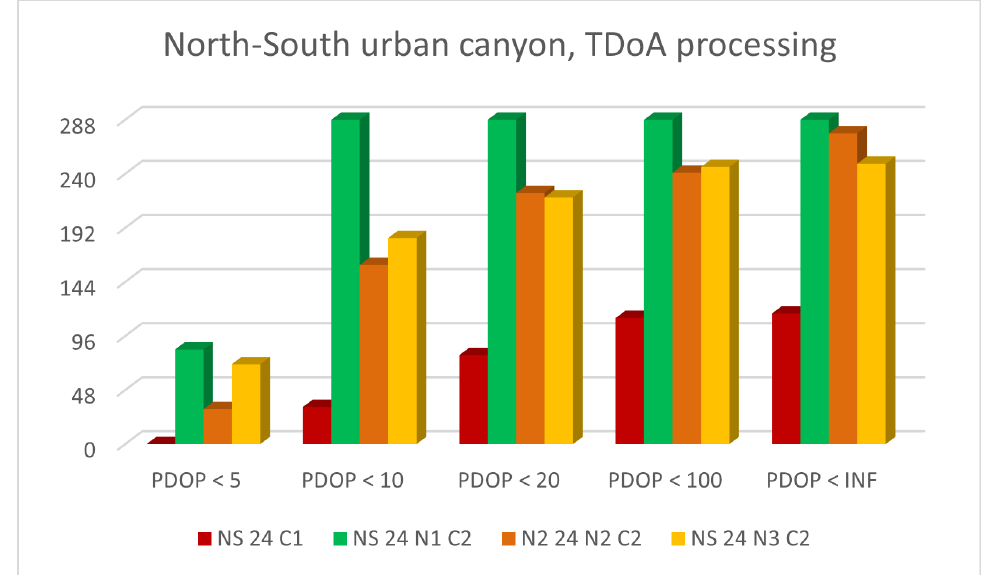
Figure 12. Number of epochs whit PDOP values smaller than 5, 10, 20, 100 or ∞ for north-south urban canyon with CG, N5-CG-TDoA, N4-CG-TDoA and N3-CG-ToA signal